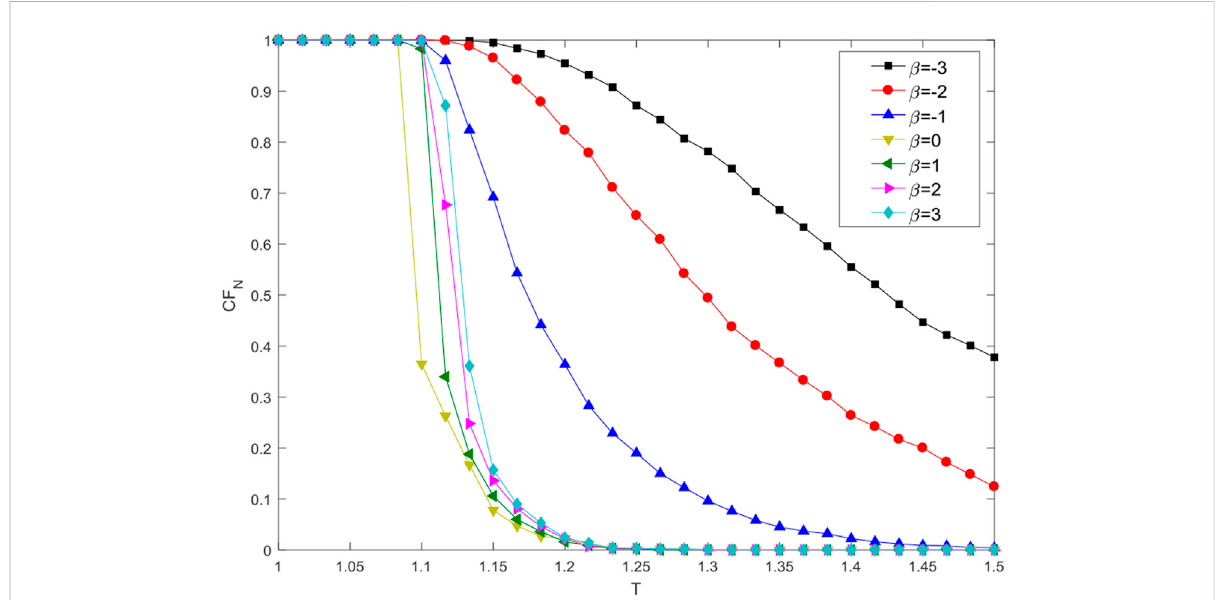
FIGURE 5 Effect of redundancy parameter T on the cascading failures performance, with different values of β . α (cid:1) 1 in the simulations.